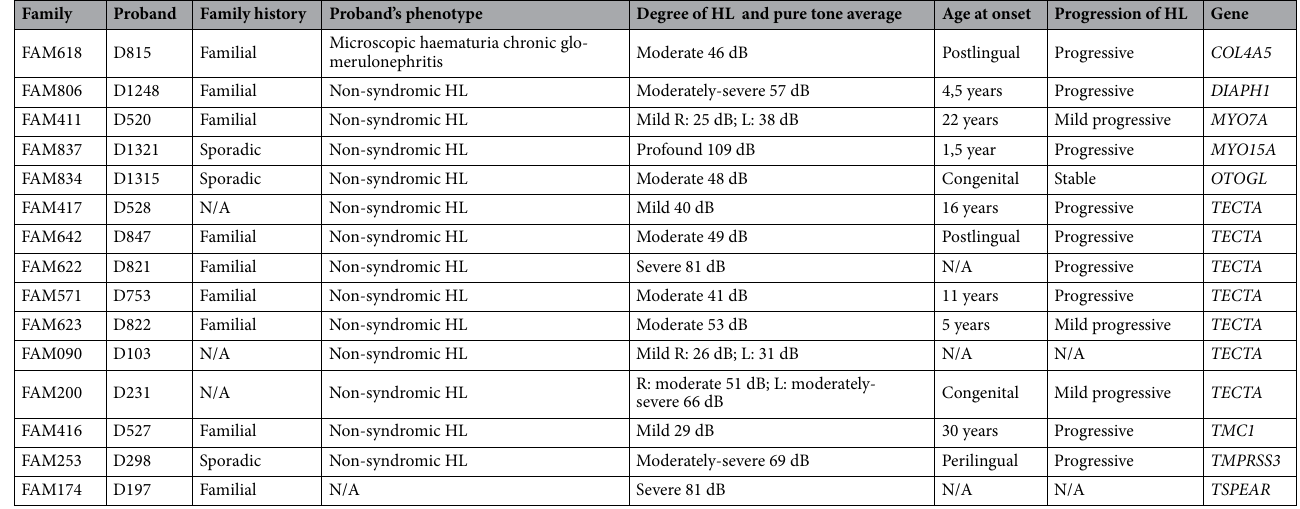
Table 1. Phenotype in 15 probands with mid-frequency SNHL. N/A, not